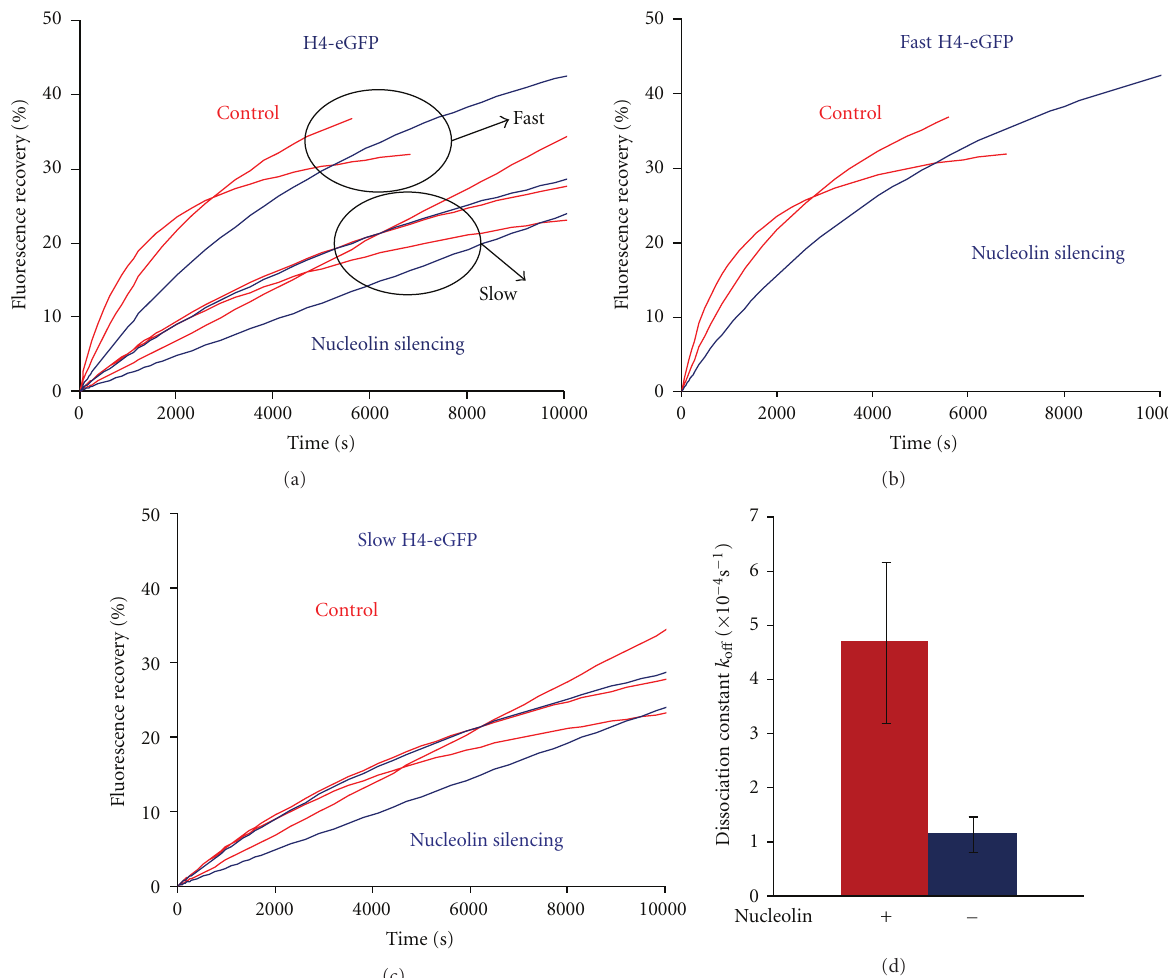
Figure 4: Nucleolin depletion does not impact H4-eGFP fluorescence recovery kinetics. (a) Normalized fluorescence recovery (%) of H4-eGFP in the nucleoplasm of control untransfected cells (red, 5 cells) and in cell transfected with siRNA against nucleolin (blue, 3 cells). Each curve represents the fluorescence recovery of a single cell. (b) Normalized fluorescence recovery (%) of H4-eGFP with a faster recovery kinetics: control untransfected cells (red, 2 cells) and siRNA against nucleolin transfected cells (blue, 1 cell). Each curve represents the fluorescence recovery of a single cell. (c) Normalized fluorescence recovery (%) of H4-eGFP with a slower recovery kinetics: control untransfected cells (red, 3 cells) and siRNA against nucleolin transfected cells (blue, 2 cells). Each curve represents the fluorescence recovery of a single cell. (d)/Dissociation rate constant values k o ff (s − 1 ) of H4-eGFP in control untransfected (red) and nucleolin depleted cells (blue).